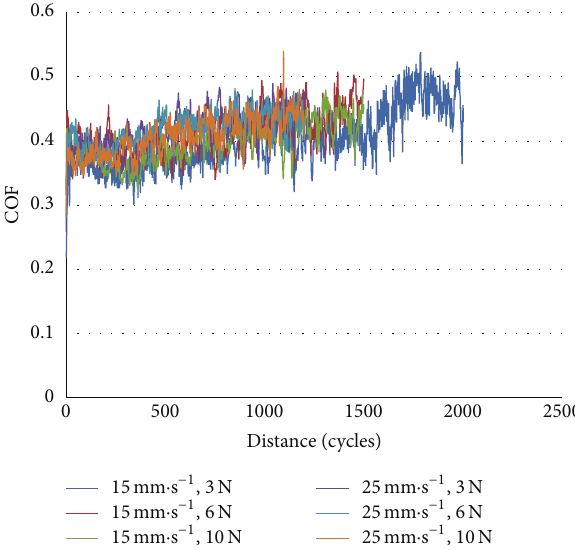
Figure 10: Friction coefficient of Ti-6Al-4V alloy versus sliding at tow sliding speed (15 and 25 mm ⋅ s −1 ).